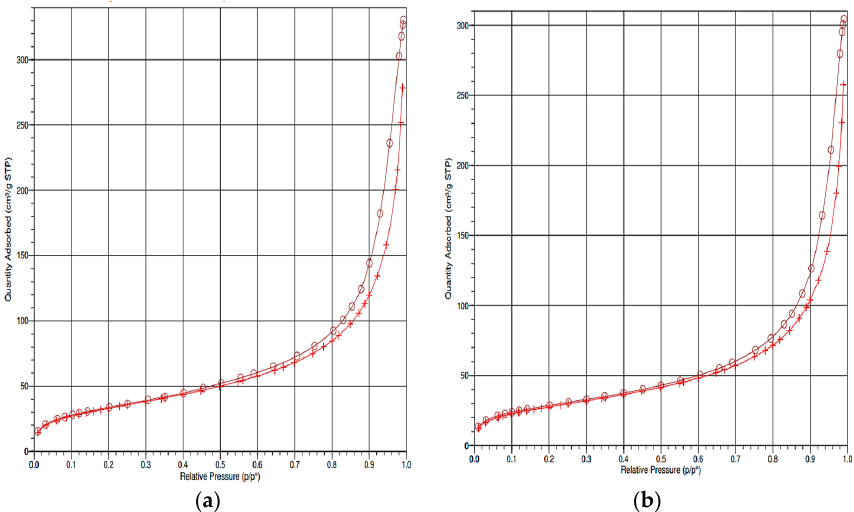
Figure 4. The N 2 adsorption-desorption isotherm of BET analysis of Seplite LX120: ( a ) before immobilization; ( b ) after immobilization of EstD9. Desorption is denoted with symbol ( ө ), while adsorption is represented with symbol (+).